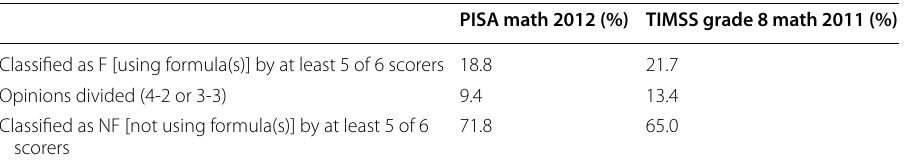
Table 1 Classification of PISA and TIMSS grade 8 items using the F/NF dichotomy, in per- centages of items